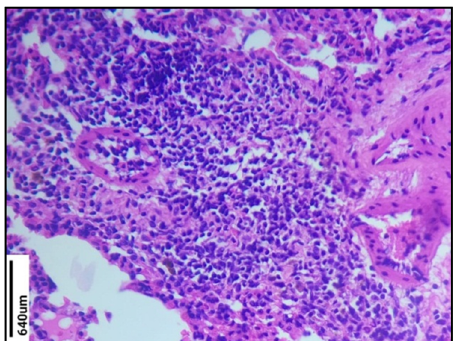
Figure 5: Histopathological study of Group VI lung section ( sensi - tized group ) . Massive in fi ltration of in fl ammatory cells in the inter - stitial space was observed in the sensitized group. The sensitized group also showed emphysema, hyperplasia, and necrosis.